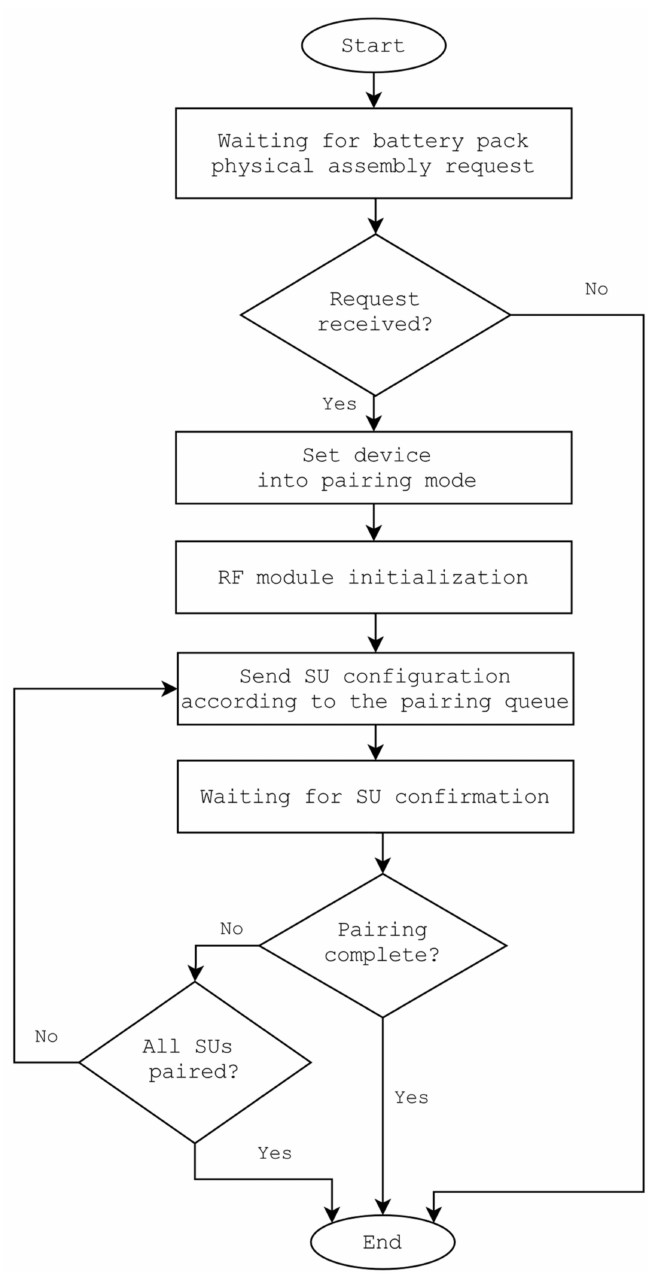
Figure 7. Algorithm of pairing Slave Units with the BMC into a modular battery